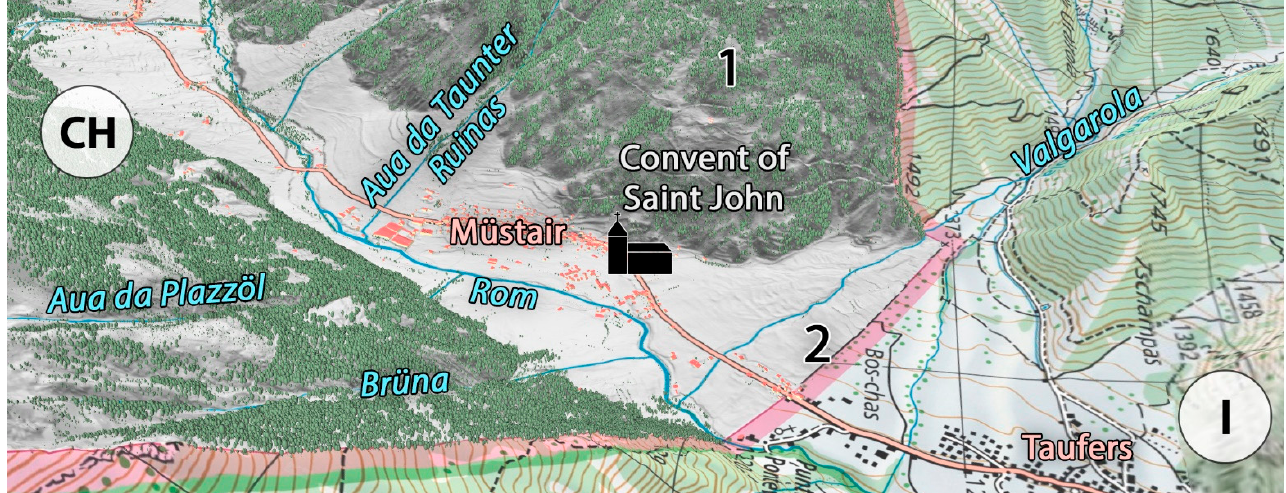
Figure 2. The topographical situation around the Convent of Saint John at Müstair. The figure depicts the main river Rom and its tributaries: Aua da Taunter Ruinas, ("Aua da" meaning "water from"), Aua da Plazzöl, and Valgarola. In addition, there is also a small creek from the Brüna valley. ( 1 ) indicates the Ruinatscha slope, while ( 2 ) indicates the big alluvial fan.